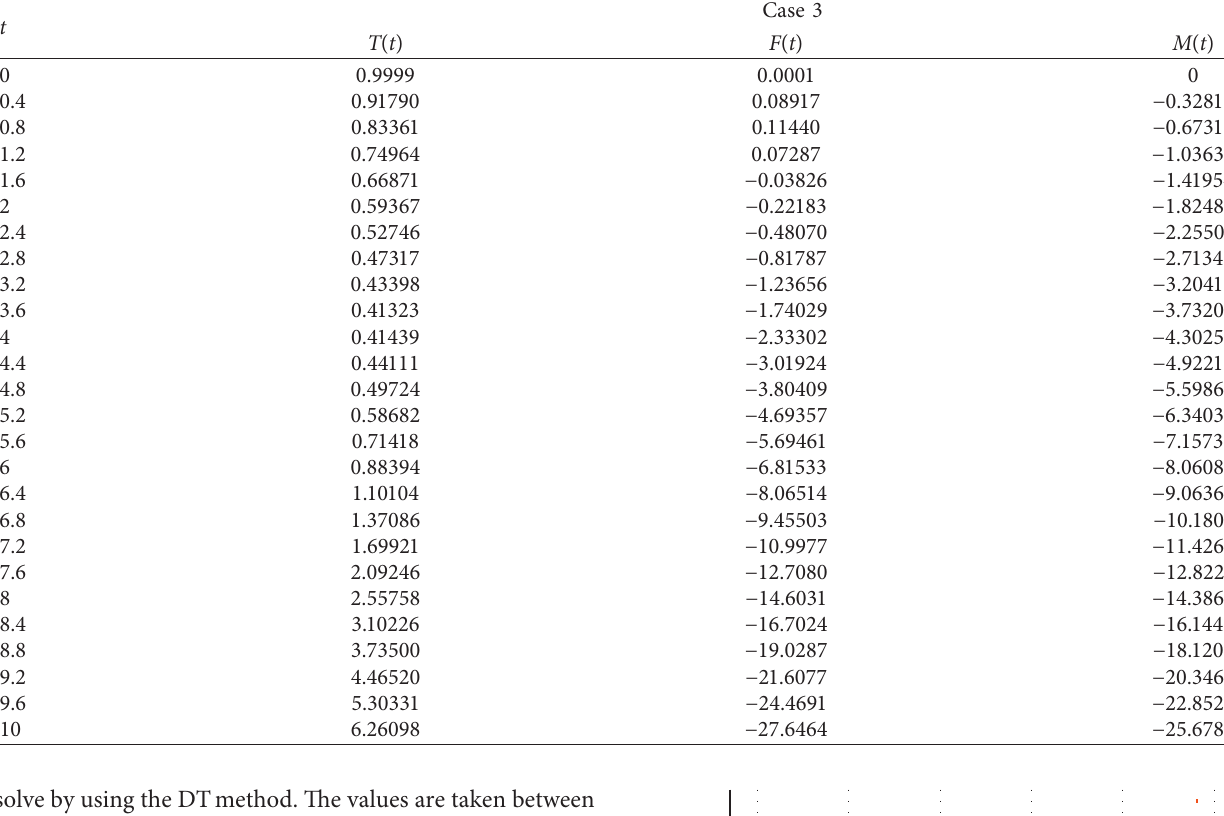
Table 4: Numerical investigations of the T ( t ), F ( t ), and M ( t ) for Case 3 of the TFM model.